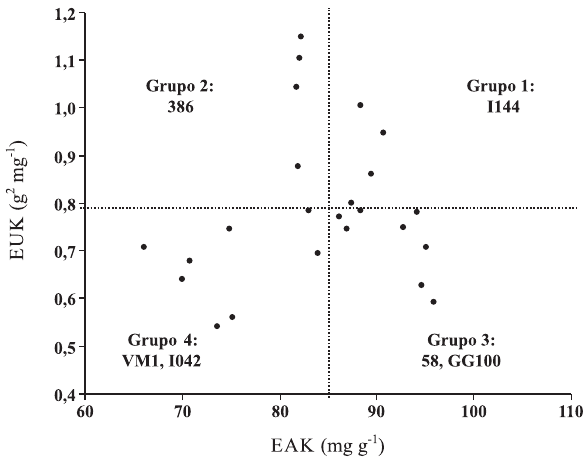
Figura 4. Diagrama de distribuição dos clones de eucalipto em função das eficiências de absorção (EA) e de utilização (EU) de potássio.